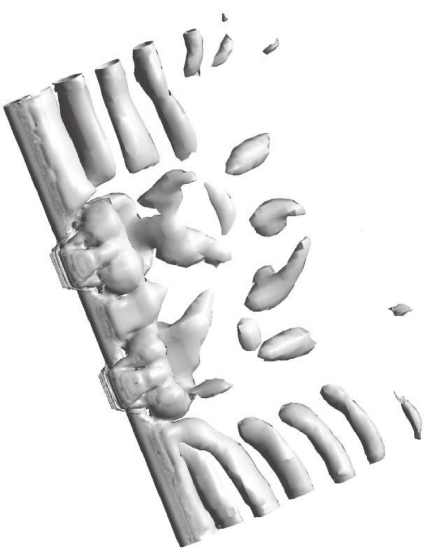
Figure 9: Vortex cores (with